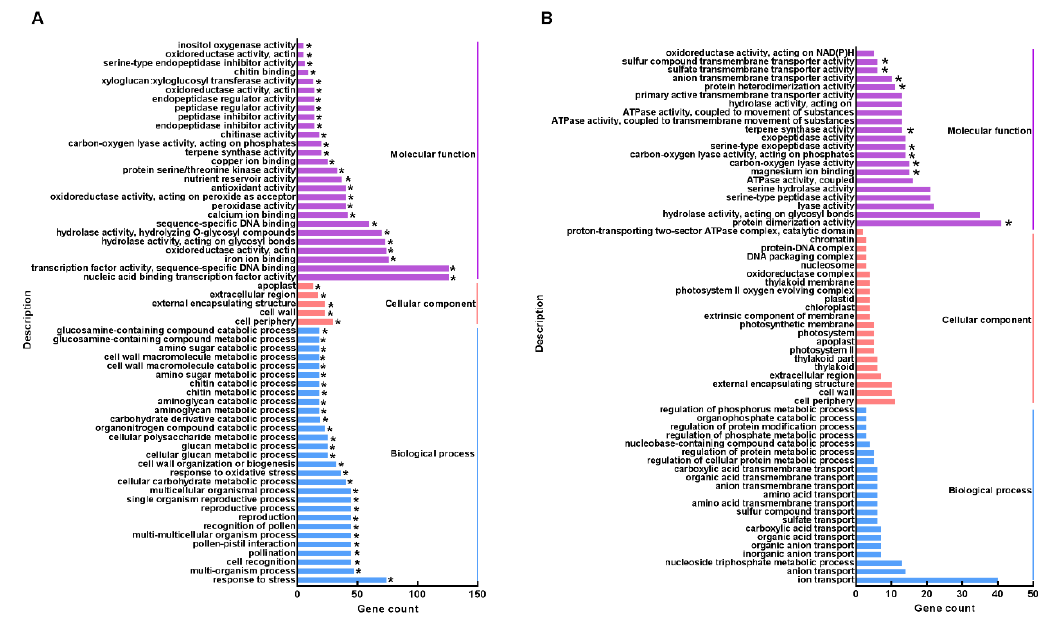
Figure 1. Gene ontology term enrichment analysis of the up- ( A ) and downregulated ( B ) differentially expressed genes (DEGs) in the comparison of trichomes vs. leaves. * indicates the significantly enriched terms.